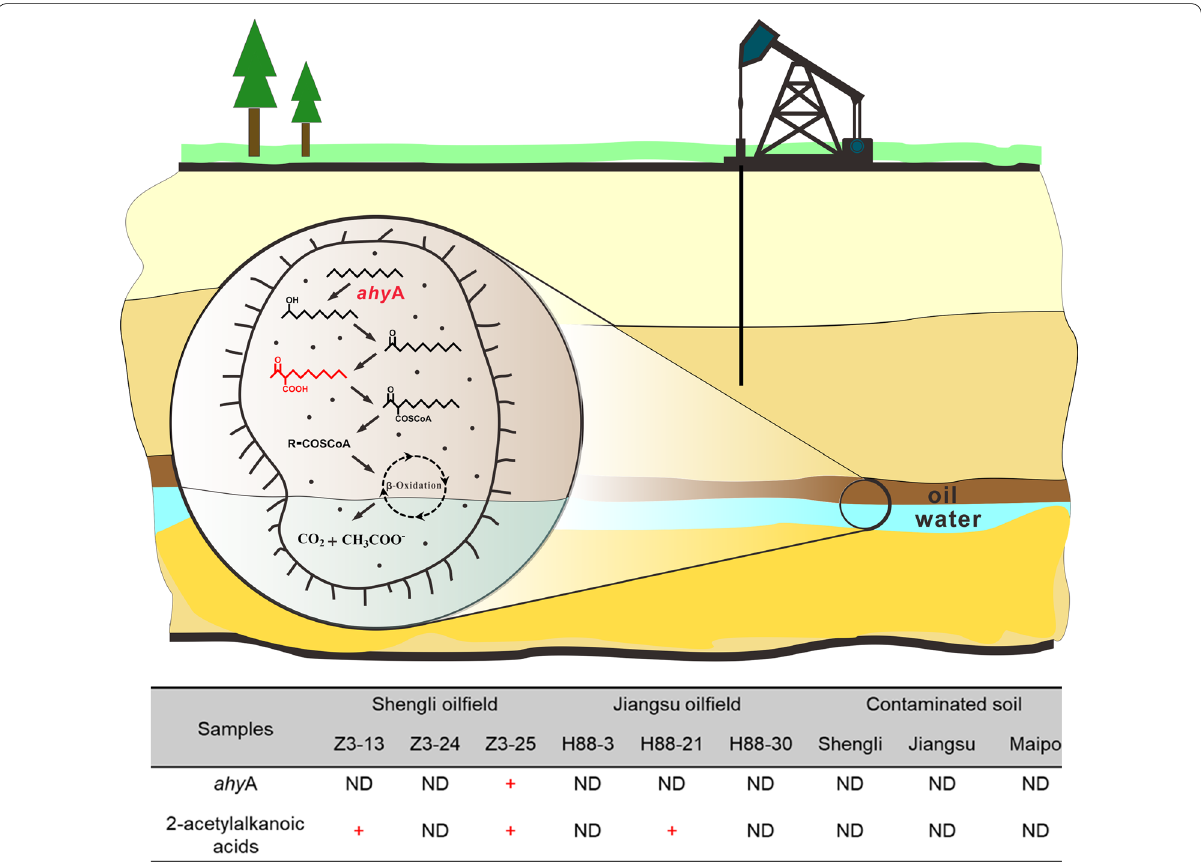
Fig. 4 The signature metabolite and functional gene detected in samples. Red “ production water sample